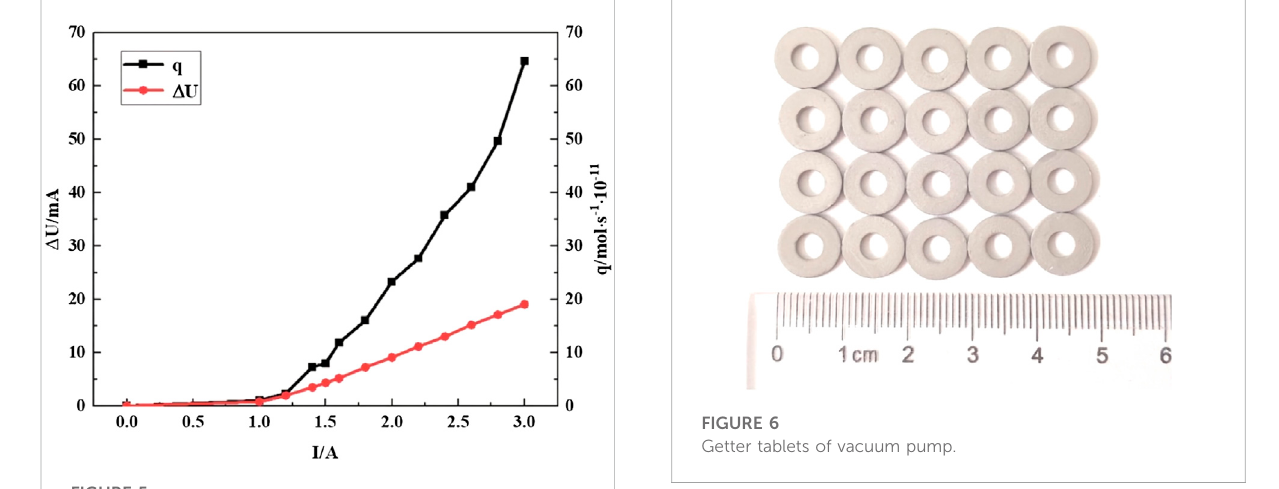
FIGURE 5 Relation curveof operatingcurrentofnickeltube and Δ U and fl ow of hydrogen.